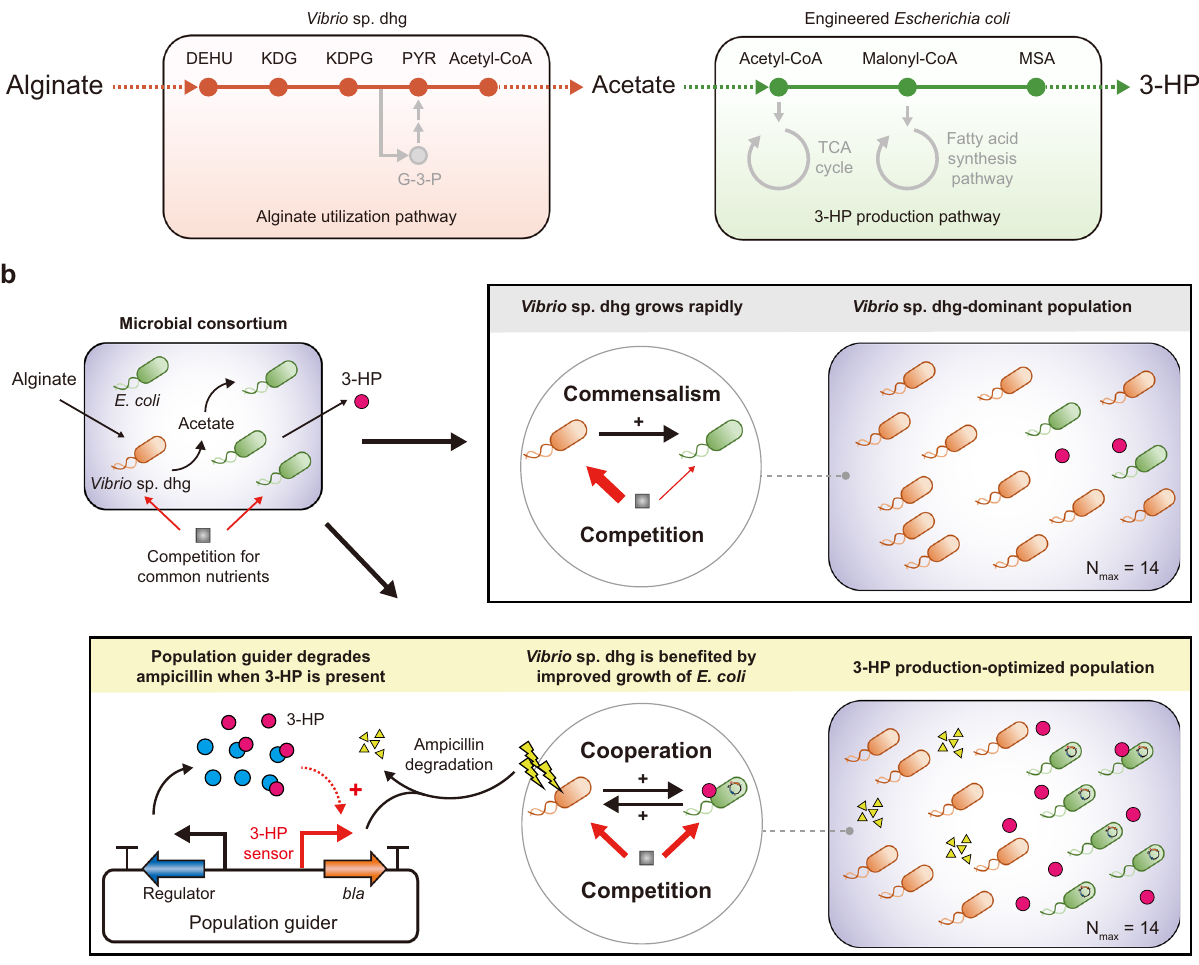
Fig. 1 | Overall strategy of genetic circuit-guided acclimation of the microbial consortium for improved 3-hydroxypropionic acid (3-HP) production. a Schematic diagram of the 3-HP biosynthesis from alginate by the microbial consortium comprising Vibrio sp. dhg and E. coli. Vibrio sp. dhg assimilates alginate and secretes acetate, whereas E. coli produces 3-HP by re-utilizing the secretedacetate.Abbreviations:3-HP,3-hyroxypropionicacid;DEHU,4-deoxy- L-erythro-5-hexoseulose uronate; KDG, 2-keto-3-deoxygluconate; KDPG, 2- keto-3-deoxy-6-phosphogluconate; PYR, pyruvate; G-3-P, glyceraldehyde 3-